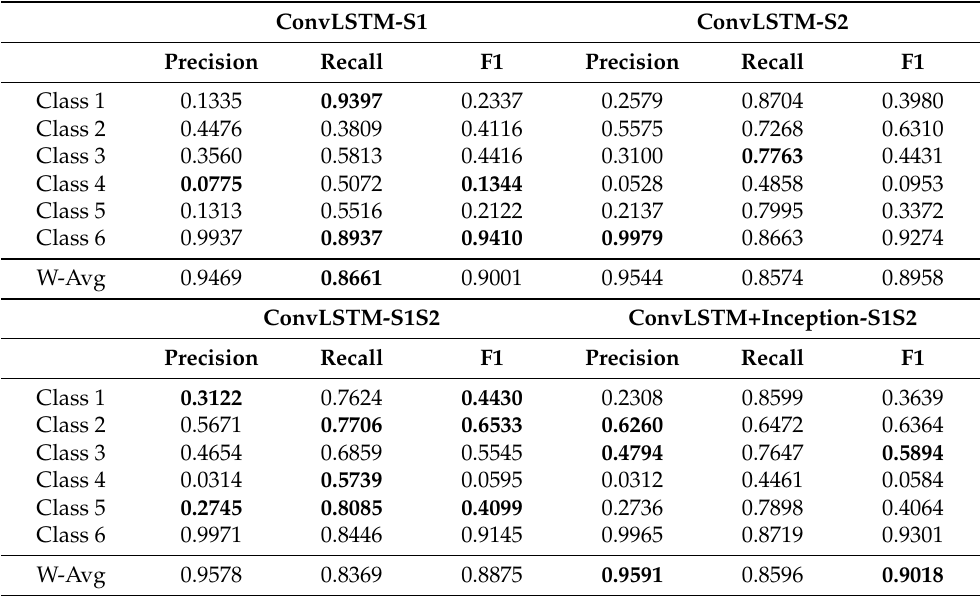
Table 5. Results of all methods for the test zone located in the north of Strasbourg, Grand-Est, France (In bold the higher value for each metric and for each